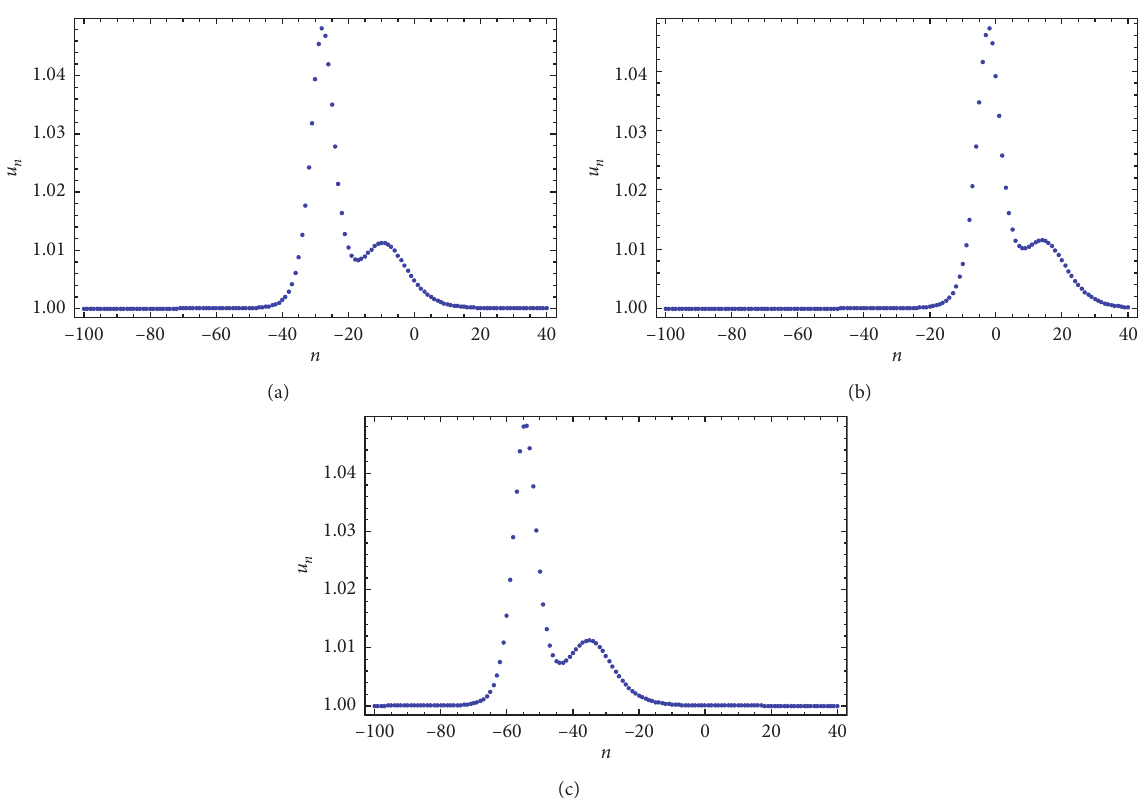
Figure 10: Dynamical evolution of the semidiscrete two-soliton solution determined by solution (53) with the parameters α � t 2 , α � t 3 , c ( 0 ) � 1, c ( 0 ) � 5 . 5, z � 0 . 8, and z � 0 . 9. (a) t � − 2. (b) t � 0. (c) t � α 2 3 1 2 1 2